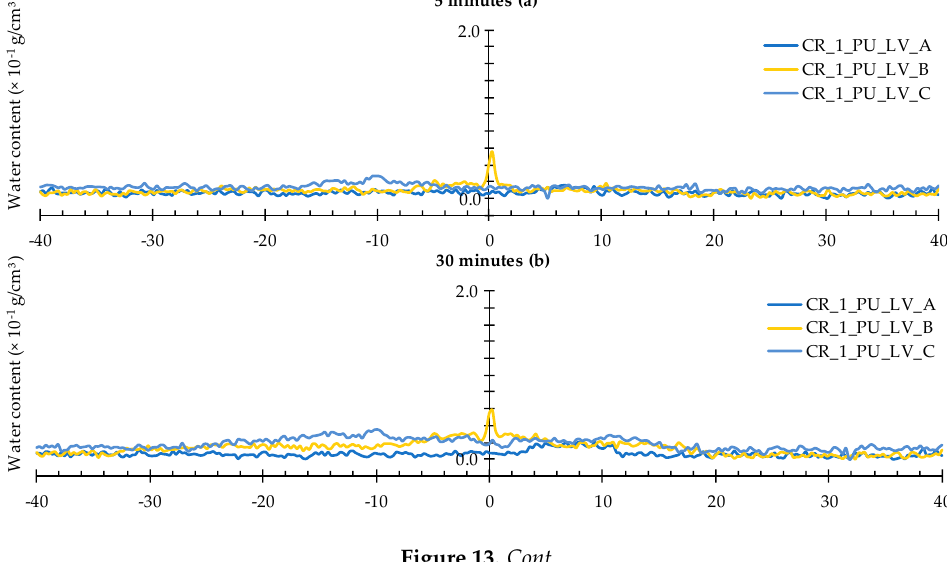
Figure 13. Cont. Figure 13.